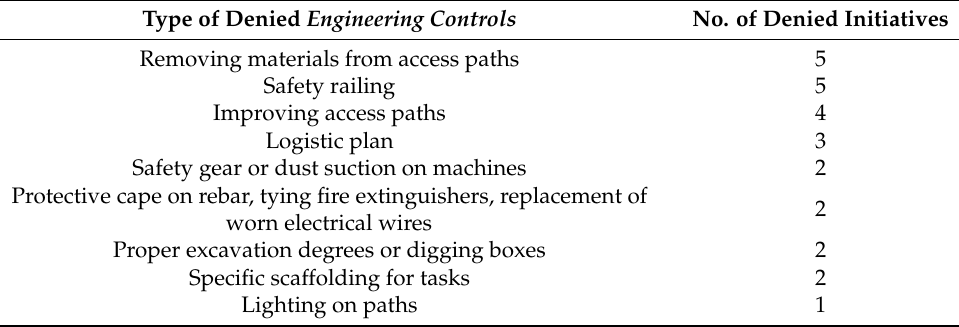
Table 5. Subcategories of denied engineering controls .